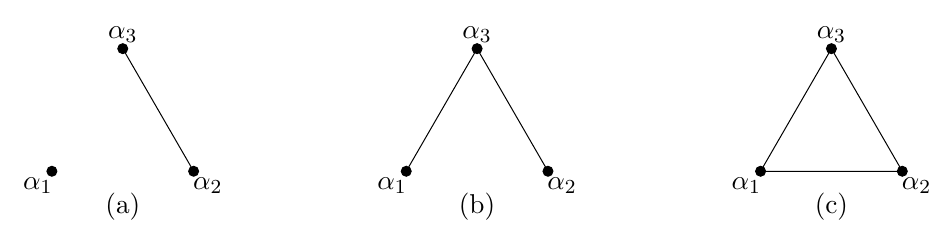
Figure 2 . Intersection graphs corresponding to the contraction diagrams of (cid:12)gure 1 in the same order from the left to the right. (a) has V = 3 and E = 1, (b) has V = 3 and E = 2, (c) has V = 3 and E =